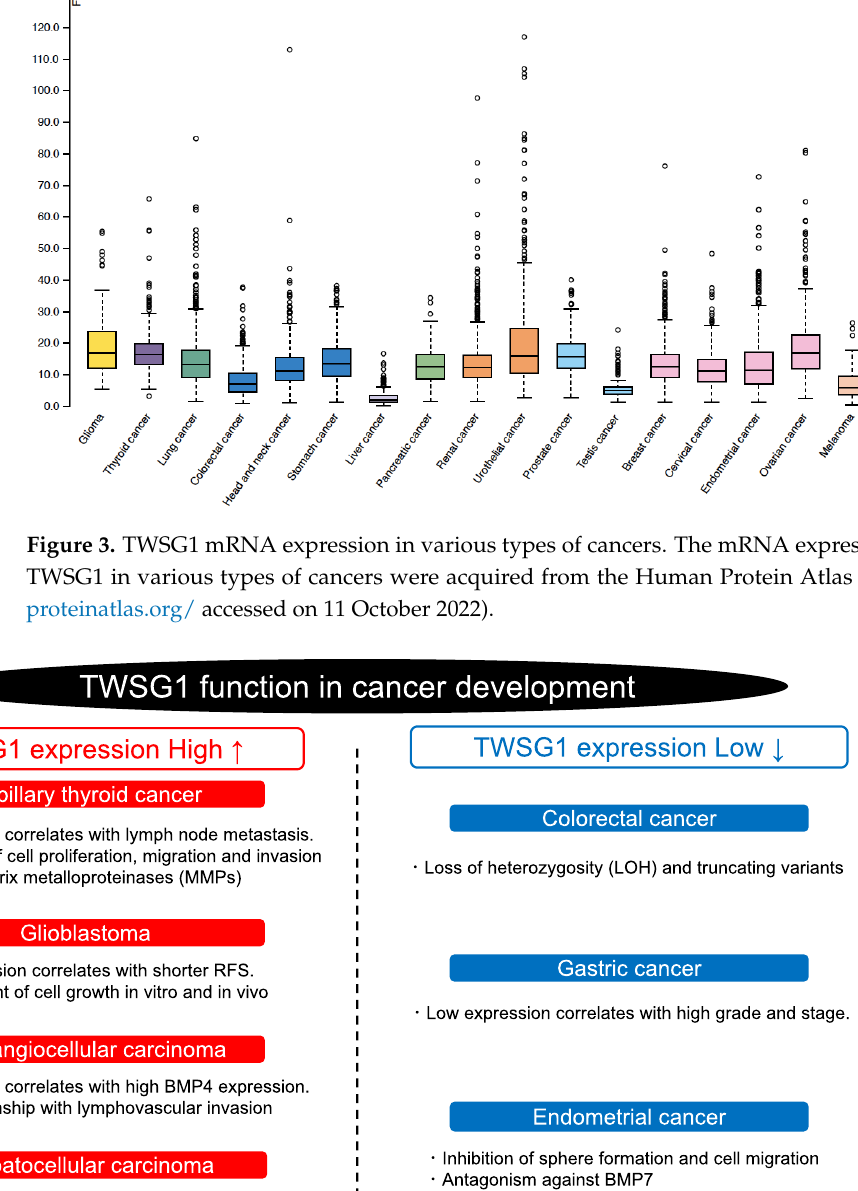
Figure 4. TWSG1 function in cancer development. TWSG1 has a variety of functions depending on the type of cancer. RFS (relapse-free survival).